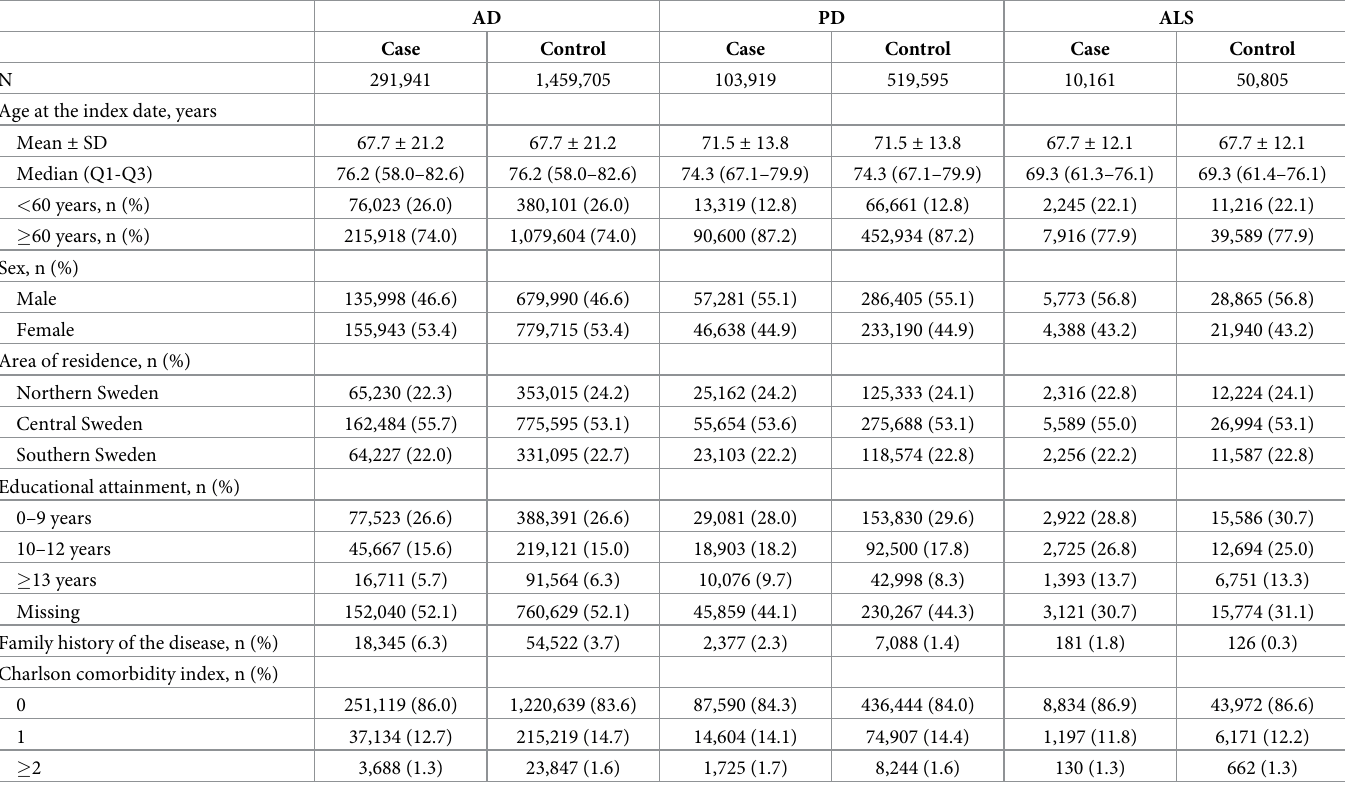
Table 1. Characteristics of patients with neurodegenerative diseases and their matched controls at the index date. AD